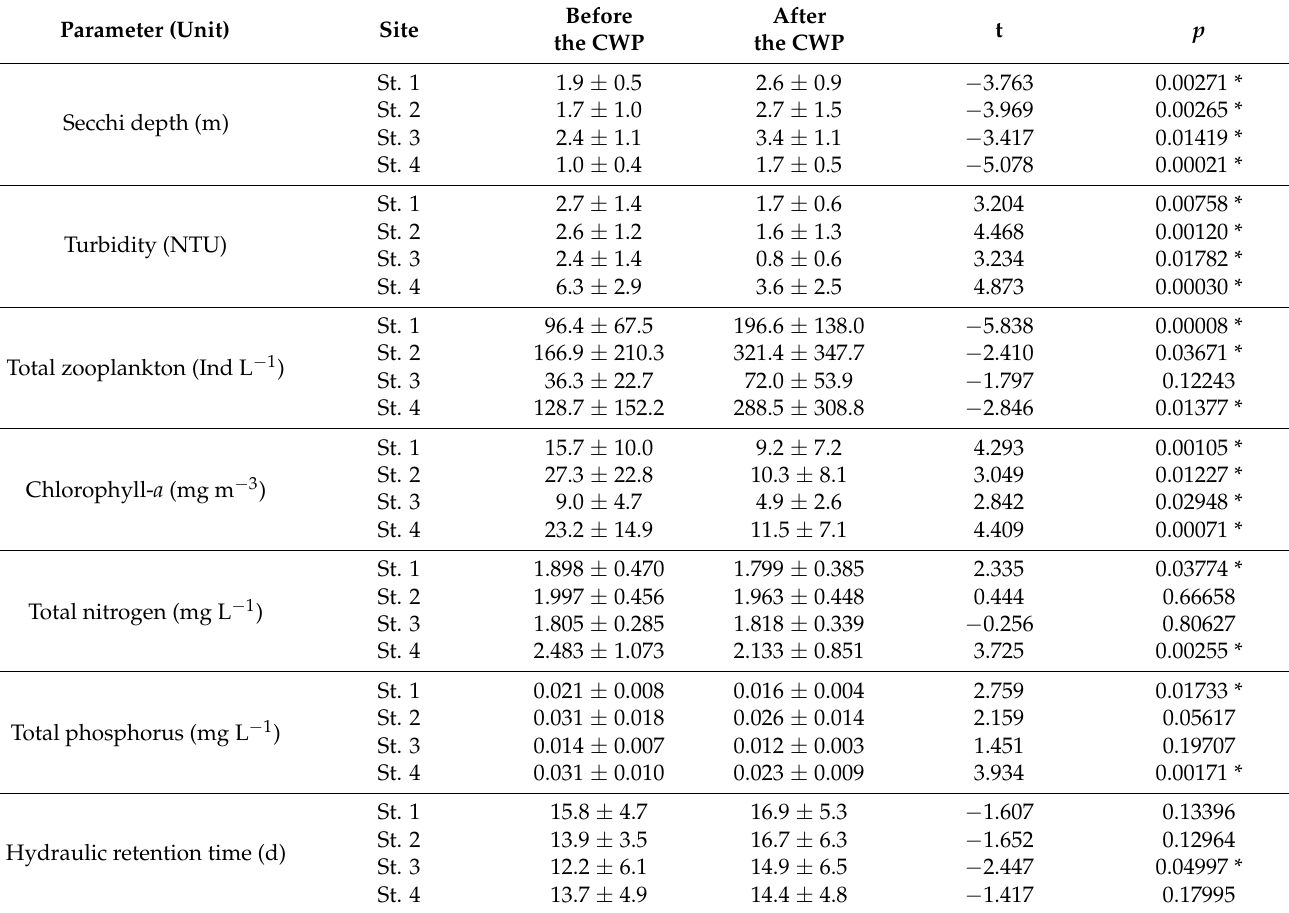
Table 2. Data for paired t-test on variable factors before and after the clear-water phase (CWP) in Lake Paldang. Parameter (Unit) Site